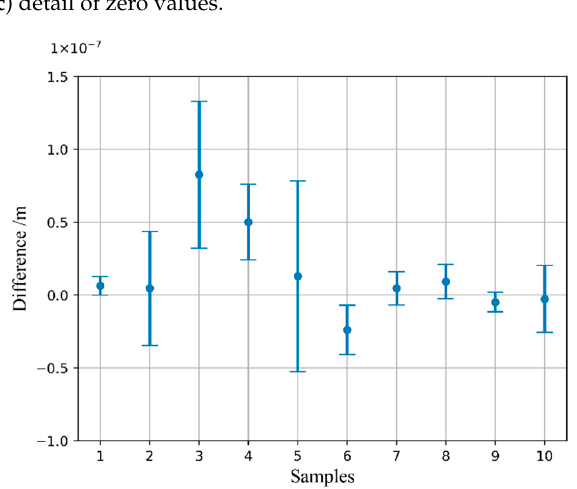
Figure 5. Differences in distance between raw data and CS recovery data.